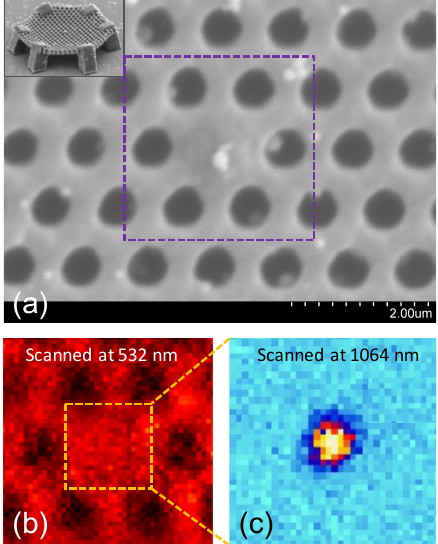
Figure 6. 3D hexagonal membrane structure containing a KTP NP. ( a ) SEM image; Inset: full side view. ( b ) Fluorescence image obtained by scanning with a 532 nm laser with low power. ( c ) SHG image, obtained by scanning with 1064 nm laser, showing the existence of a KTP NP at at center of